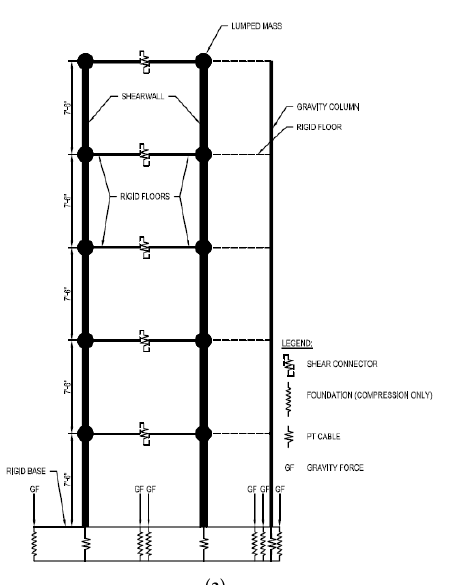
Figure 16. Ground Acceleration (Adapted from Ref. [14]). Element type COMBIN39 was used to model the bi-linear springs representing the connector devices. This type of element allows inputting the load-displacement response and can account for energy dissipation during loading and unloading. The base boundary conditions were set such that the vertical and out-of-plane horizontal movements were restrained, while in-plane horizontal movements were unrestrained. The scaled force ver- sus displacement data for the UFP and MYZ springs were obtained from the PRESSS